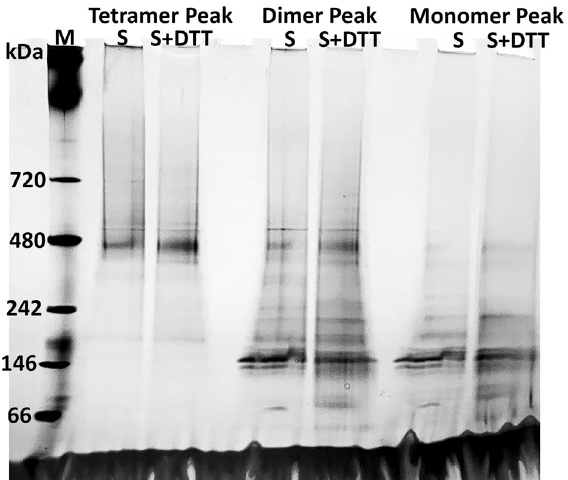
Figure 9. Silver stained clear-native PAGE of different oligomeric samples treated with or without dithiothreitol (DTT) overnight. Three peak samples, which represent the tetramer, dimer, and monomer of full-length pGC- A, were concentrated and split in half for treatment with or without DTT. S, concentrated sample only; S + DTT, concentrated sample incubated with 1 M DTT